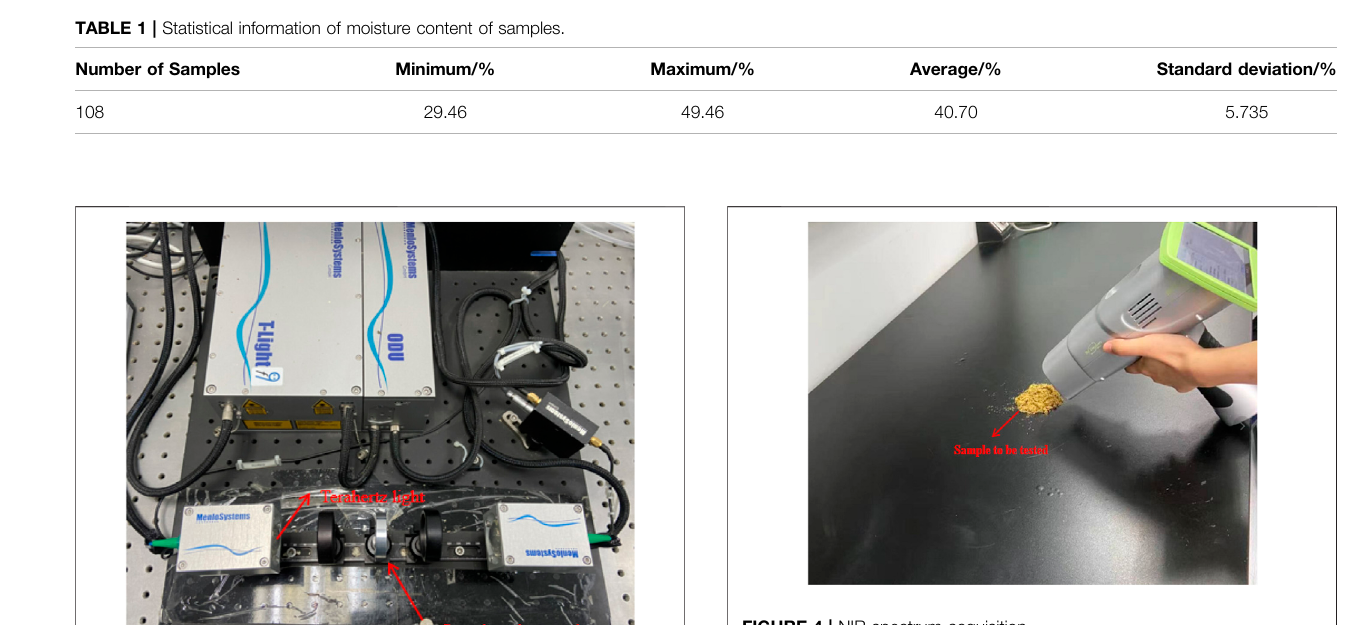
FIGURE 4 | NIR spectrum acquisition.